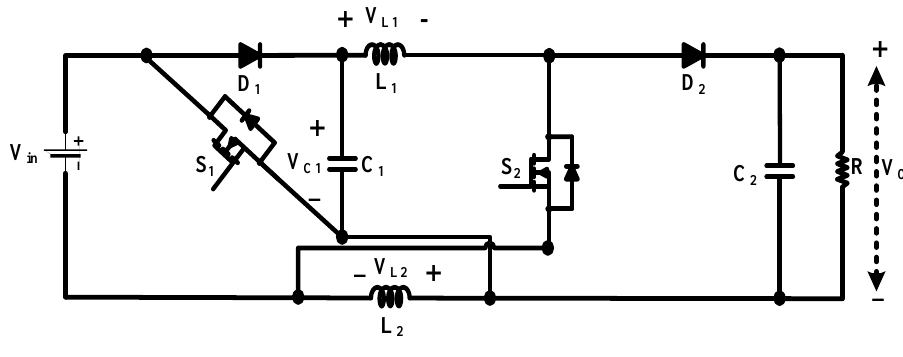
Figure 1. The proposed converter.